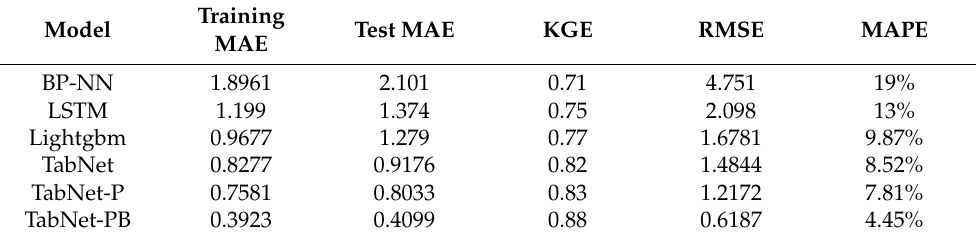
Table 8. Comparative experiment